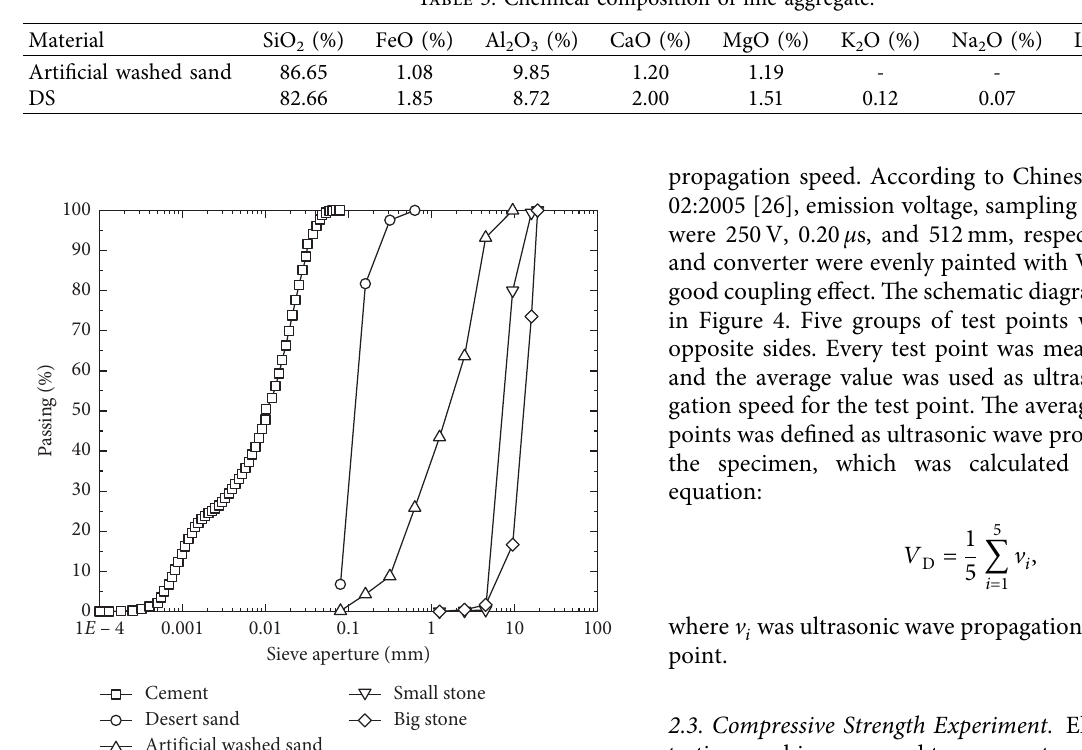
Table 3: Chemical composition of fine aggregate.